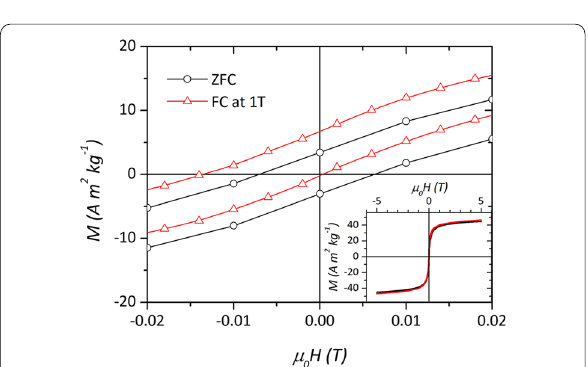
Fig. 6 Low-field magnification of M ( H ) loops recorded at 5 K after cooling the sample MAG1 from 300 K in zero field (black line and circles) and in 1 T (red line and triangles). In the inset, the extended field range of